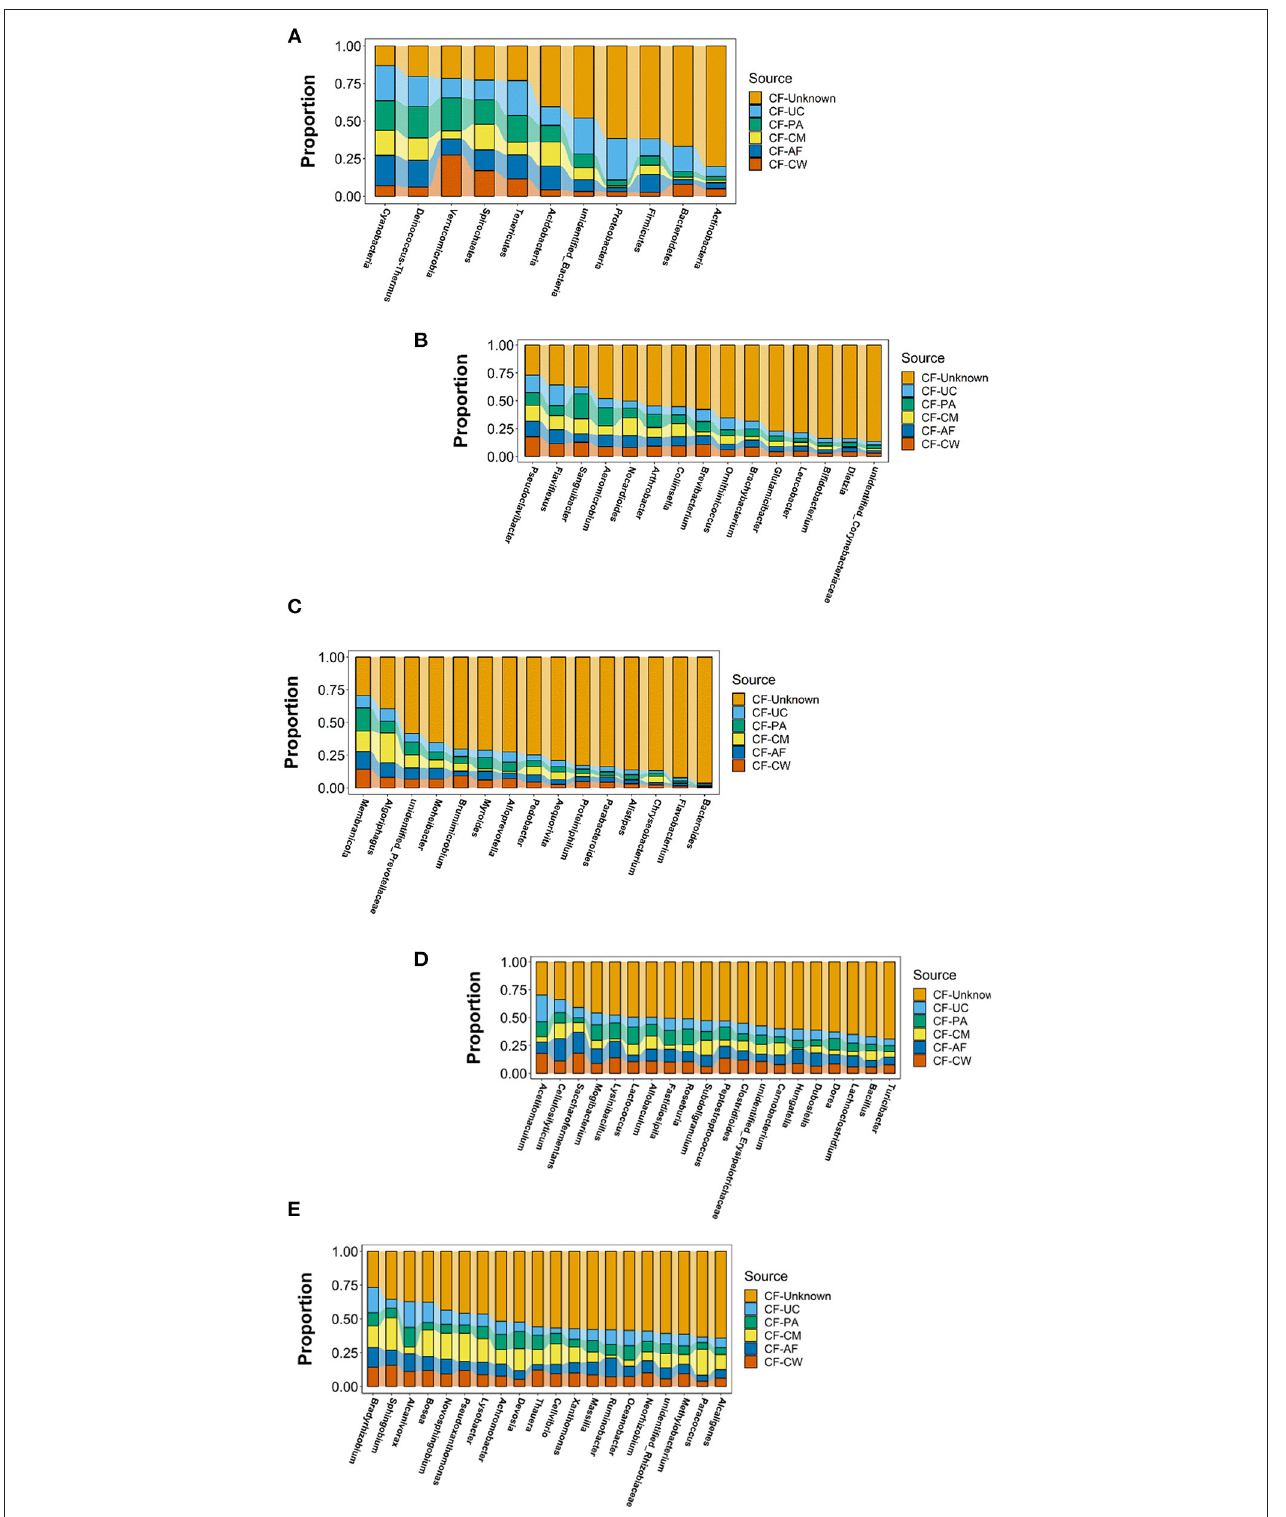
FIGURE 7 | Estimation of the matching ratio of meconium constituents to the main genera in each maternal sample type during maternal transmission. (A) Estimation of the matching proportion of the major microbiome constituents at the phylum level. (B) Estimation of the matching proportion of major microbiome constituents